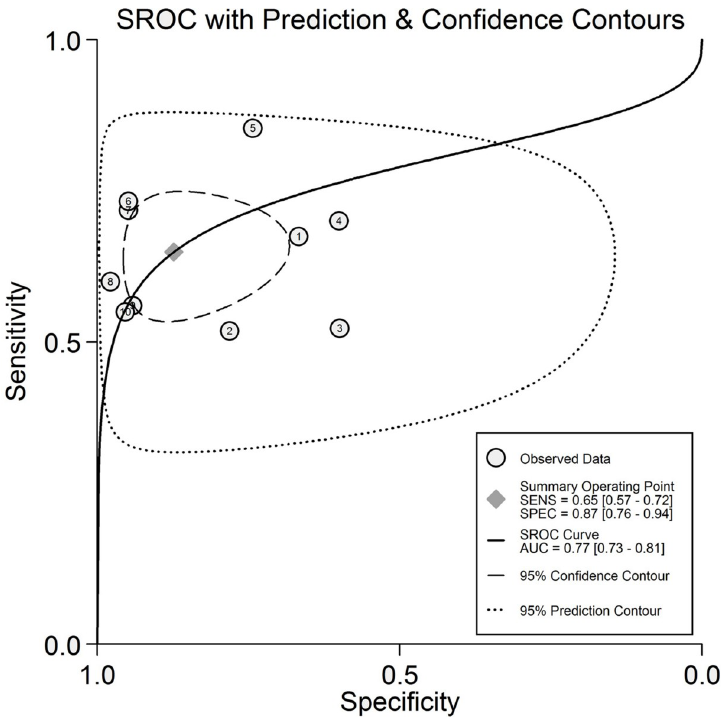
Fig 5. Summary ROC curve of the TIMP-1 diagnostic value in colorectal cancer. Every point represents an included study. The diamond shape represents the summary sensitivity and specificity. The AUC is 0.77, which implies an upper moderate diagnostic accuracy for diagnosing